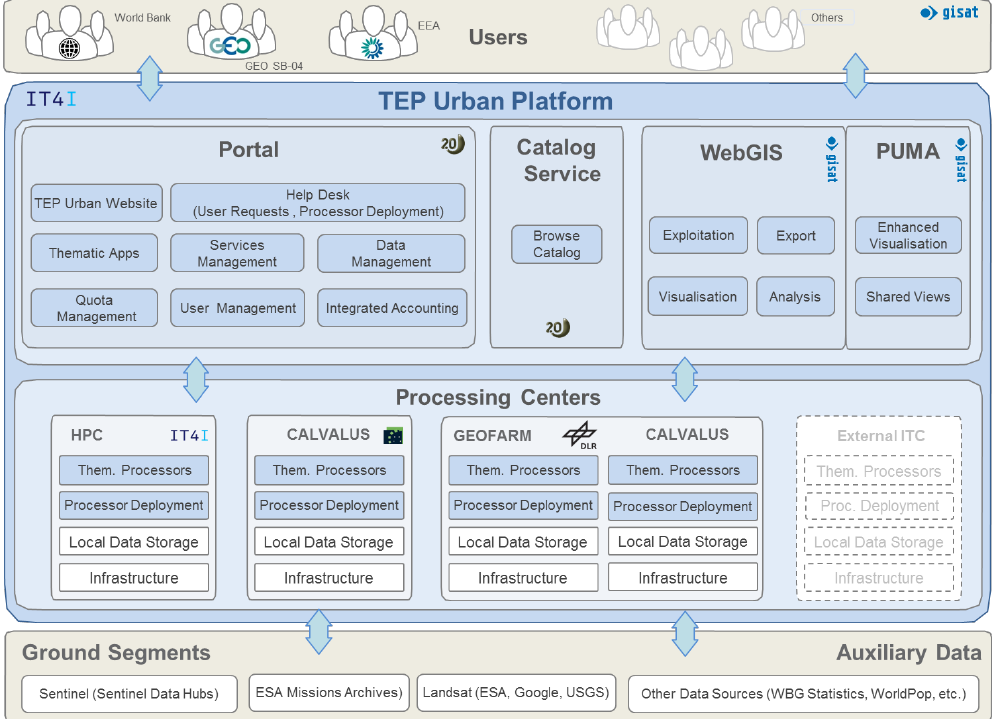
Figure 1. Schematic view of basic components of the Urban Thematic Exploitation Platform (U-TEP)